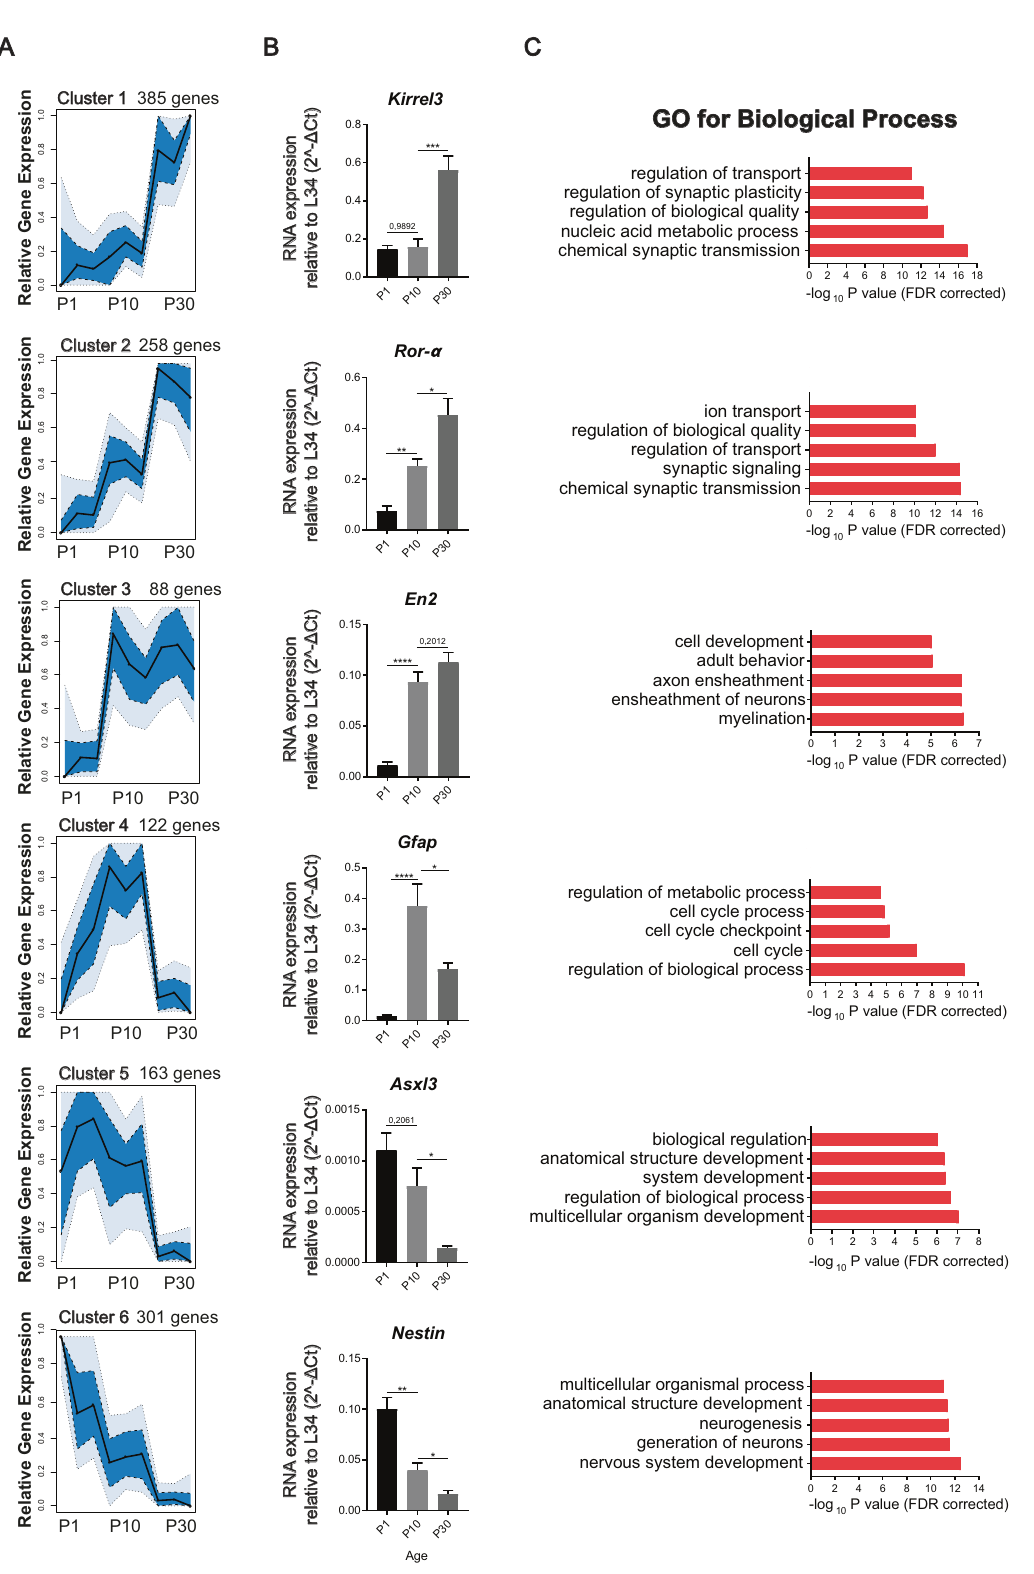
Computational analyses indicated that the 162 ASD-associated genes that are dynamically regulated during cerebellar develop- ment (Overlap group) are signi fi cantly larger than other developmental-regulated genes (GE group) or other genes